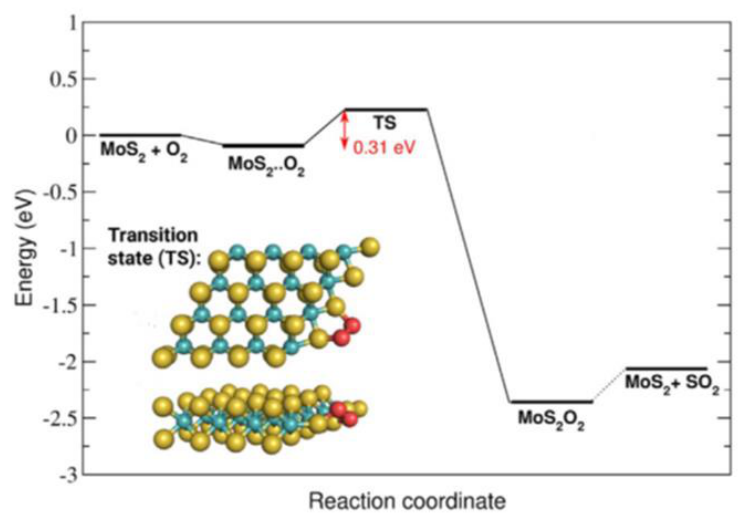
Figure 18. Single sulfur vacancy creation via dissociative O 2 splitting on the edge of the MoS 2 crystal [58]. Energy profile for the dissociative splitting of the O 2 molecule at the Mo-edge of MoS 2 and the geometry of the transition state (inset). Further reactions leading to single sulfur vacancy are also provided after the transition state. Reprinted from Reference [58], with permission.